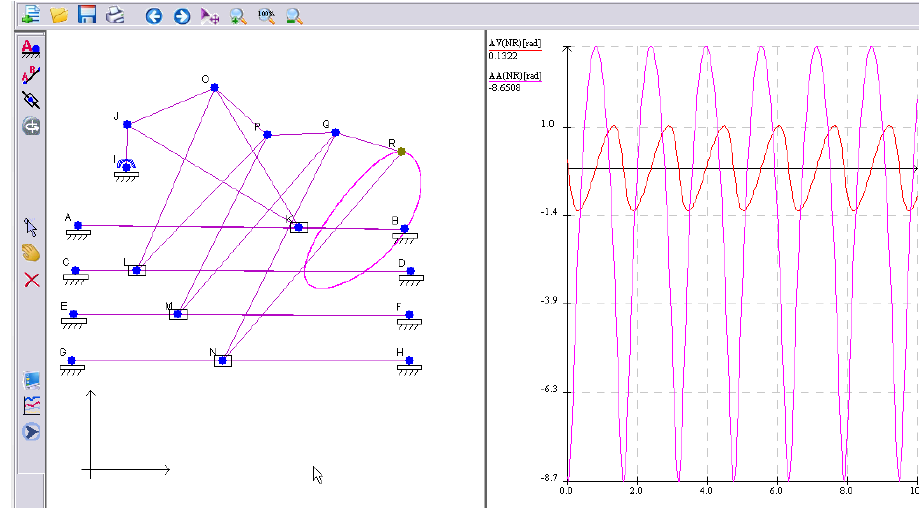
Figure 9. Simulation of an articulated manipulator, and its kinematic